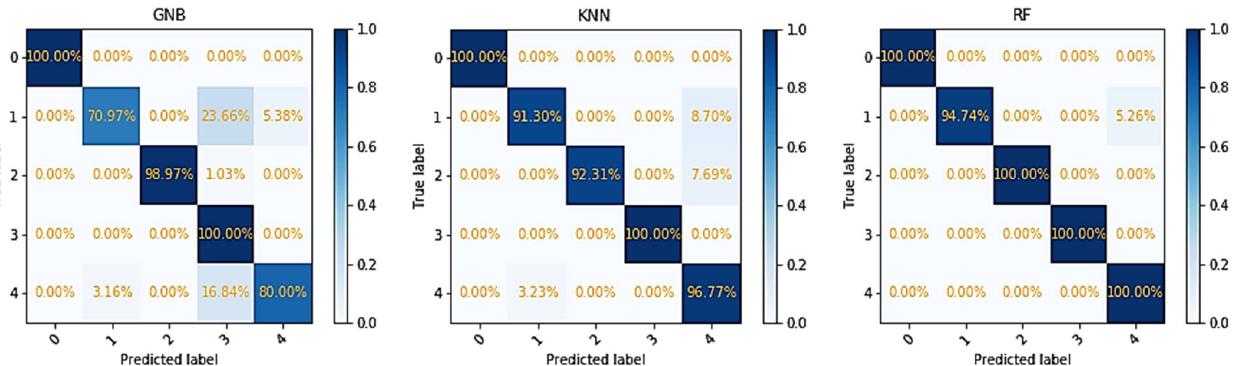
Figure 9. The confusion matrix of the recognition results for GNB, DT, KNN, RF, SVM, and DESVM machine learning algorithm.